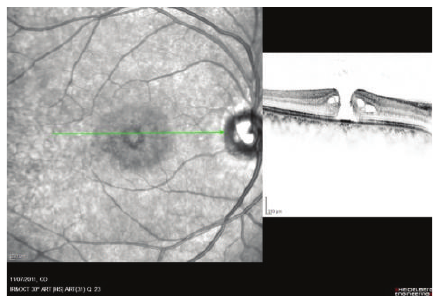
Figure 2: Spectral domain optical coherence tomography (Spec- tralis; Heidelberg Engineering, Heidelberg/Germany) of the right eye. Full thickness macular hole and no evidence of posterior vitreous detachment (stage 3).